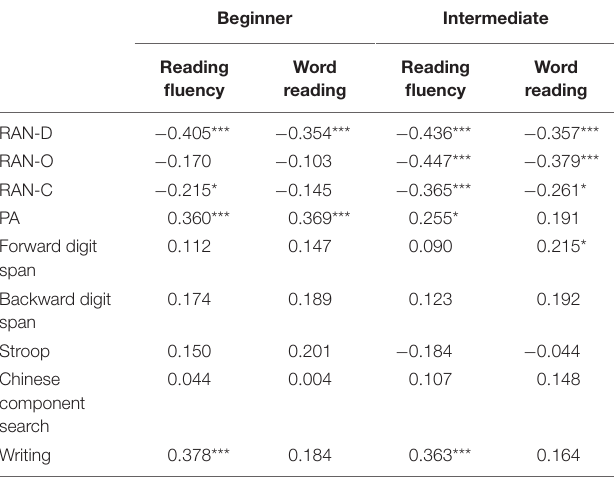
TABLE 2 | Partial correlations between reading performance and component skills, controlling for age and non-verbal